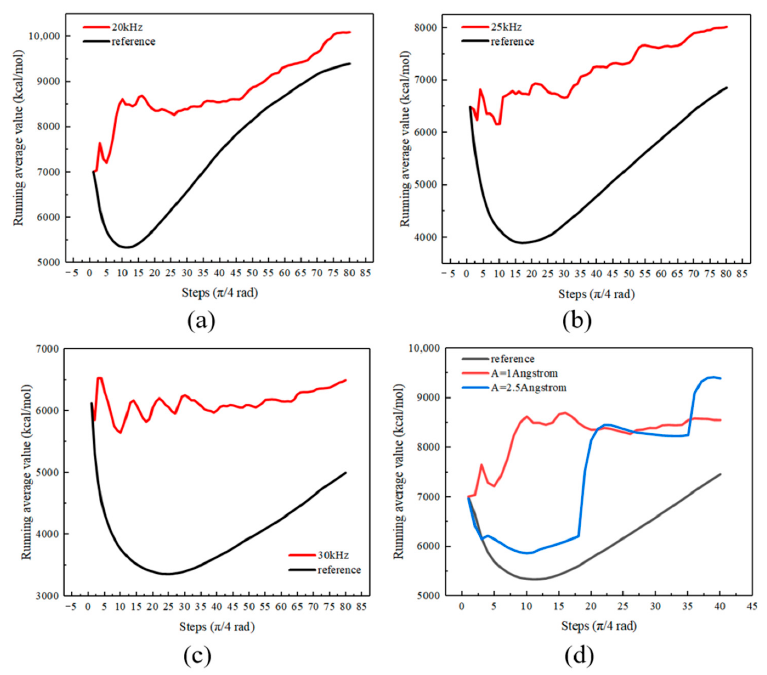
Figure 15. Average kinetic energy of adhesive molecules in the simulation of ( a ) 20 kHz, ( b ) 25 kHz, ( c ) 30 kHz and ( d ) different amplitudes. ( c ) 30 kHz and ( d ) different